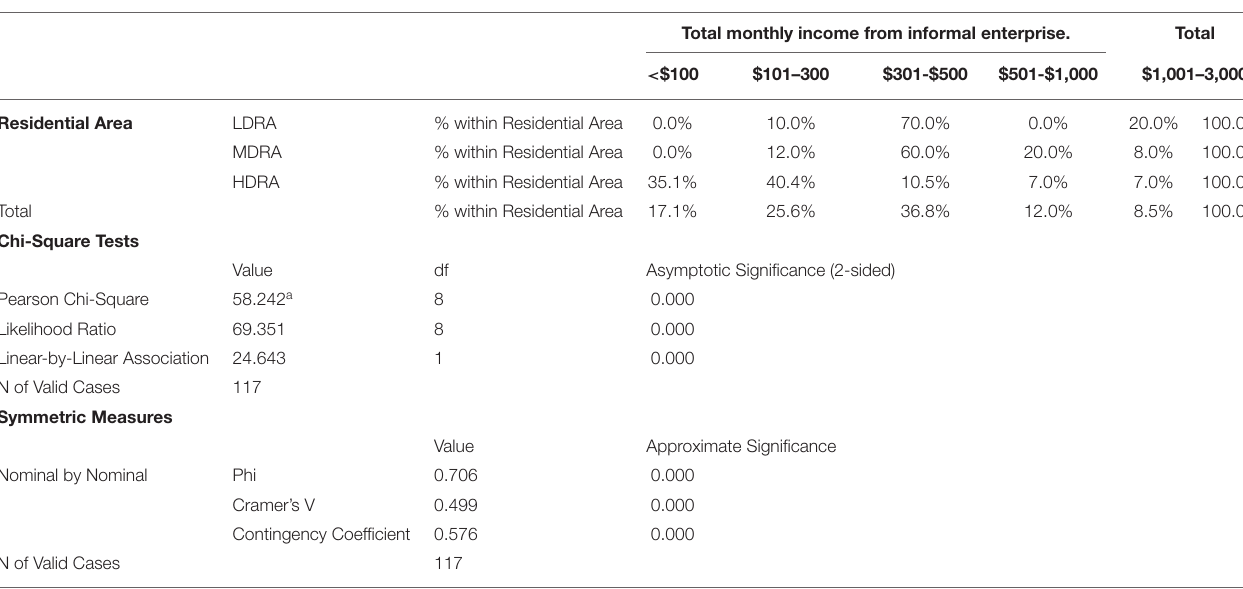
Total monthly income from informal